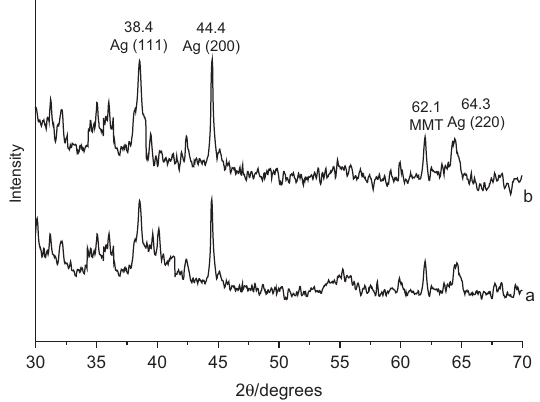
Figure 8 XRD patterns of Ag-MMT-N and Ag-MMT.